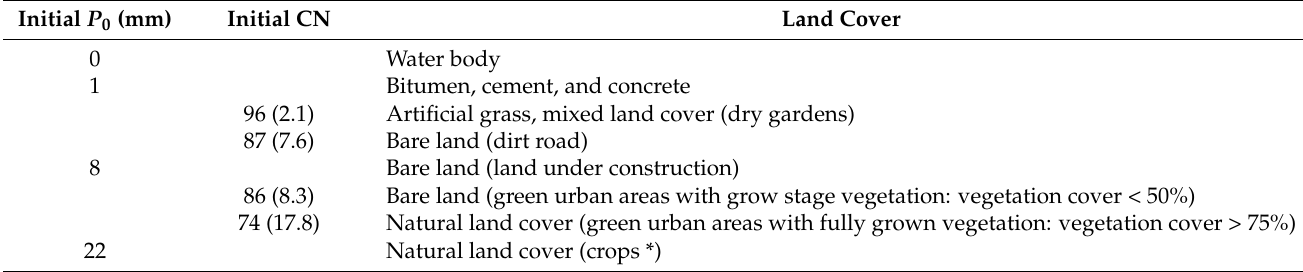
Table 2. Initial P 0 and CN values for each land-cover type in the study area for AMC II. Equivalence to P 0 for CN values after applying Equation (7) is indicated in